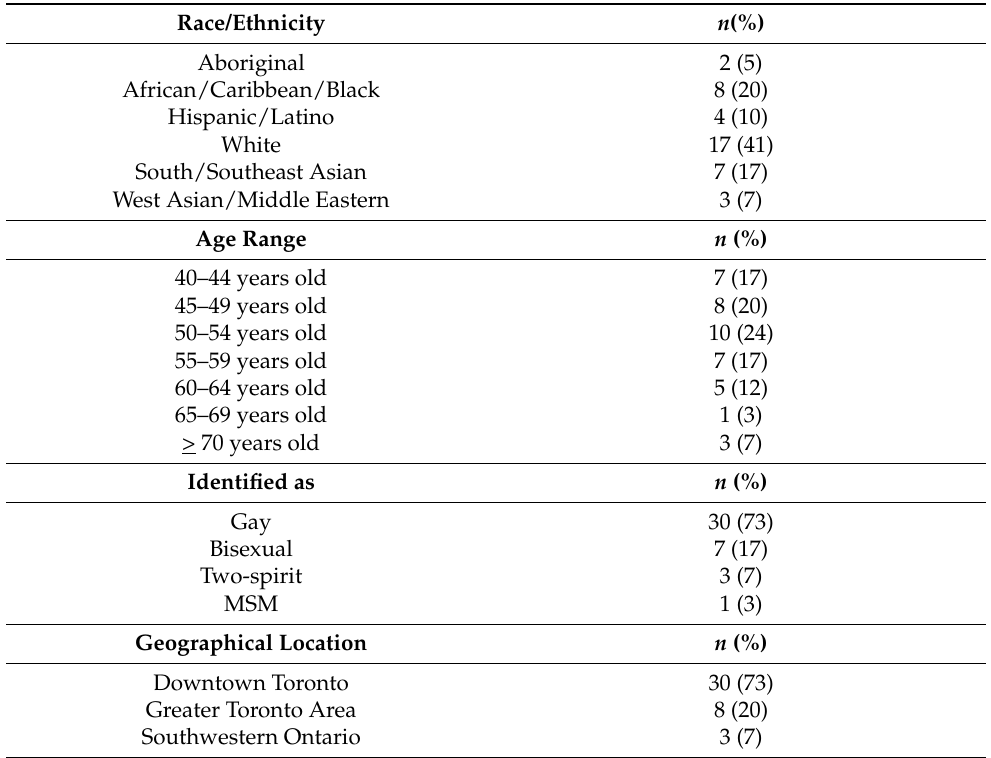
Table 1. Participant characteristics ( n =